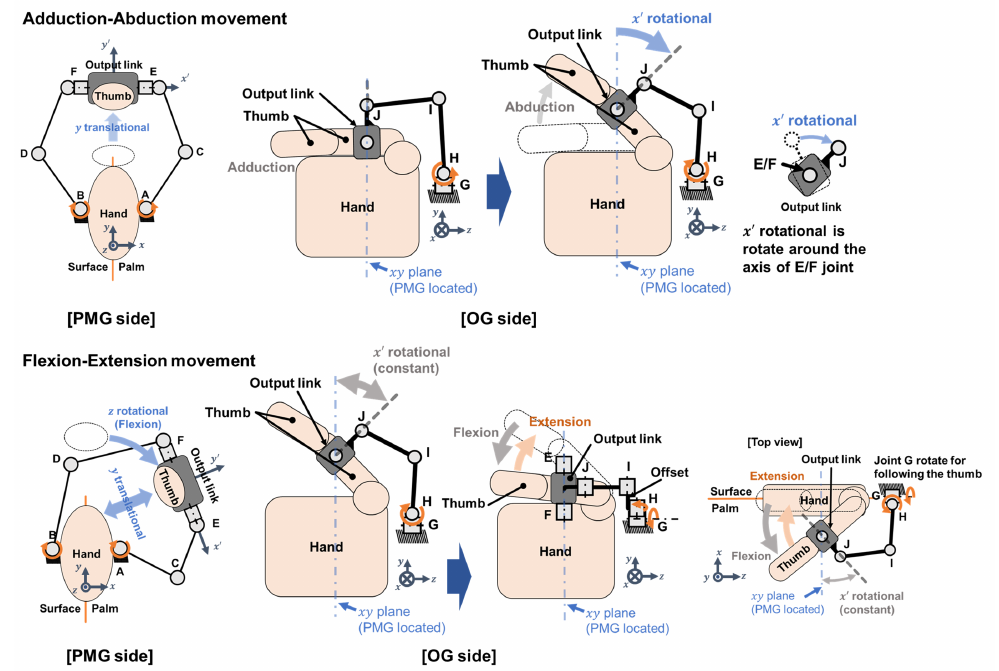
Figure 5. Explanation of the proposed mechanism’s mobility in the cases of AA and FE movement. This figure explains the movements in the side of two parts such as PMG and